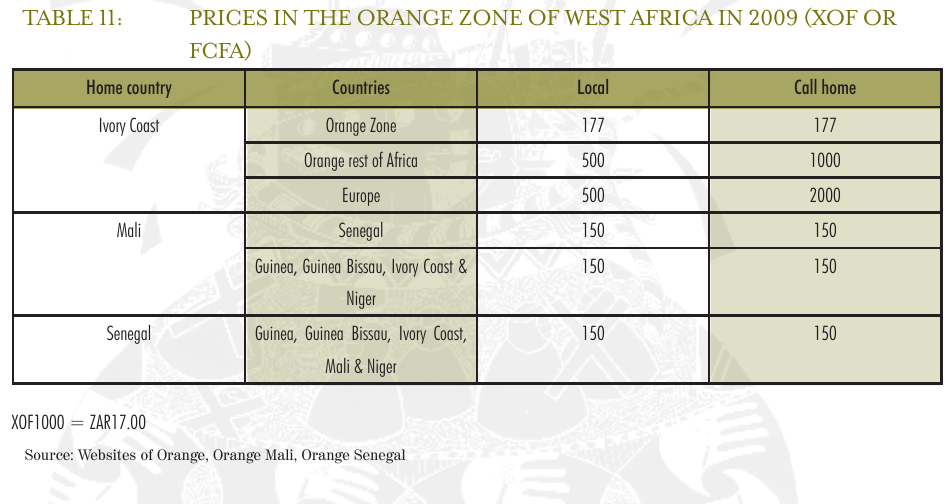
PRICES IN THE ORANGE ZONE OF WEST AFRICA IN 2009 (XOF OR FCFA) Home country Countries Local Call home Ivory Coast Orange Zone 177 177 Orange rest of Africa 500 1000 Europe 500 2000 Mali Senegal 150 150 Guinea, Guinea Bissau, Ivory Coast & Niger